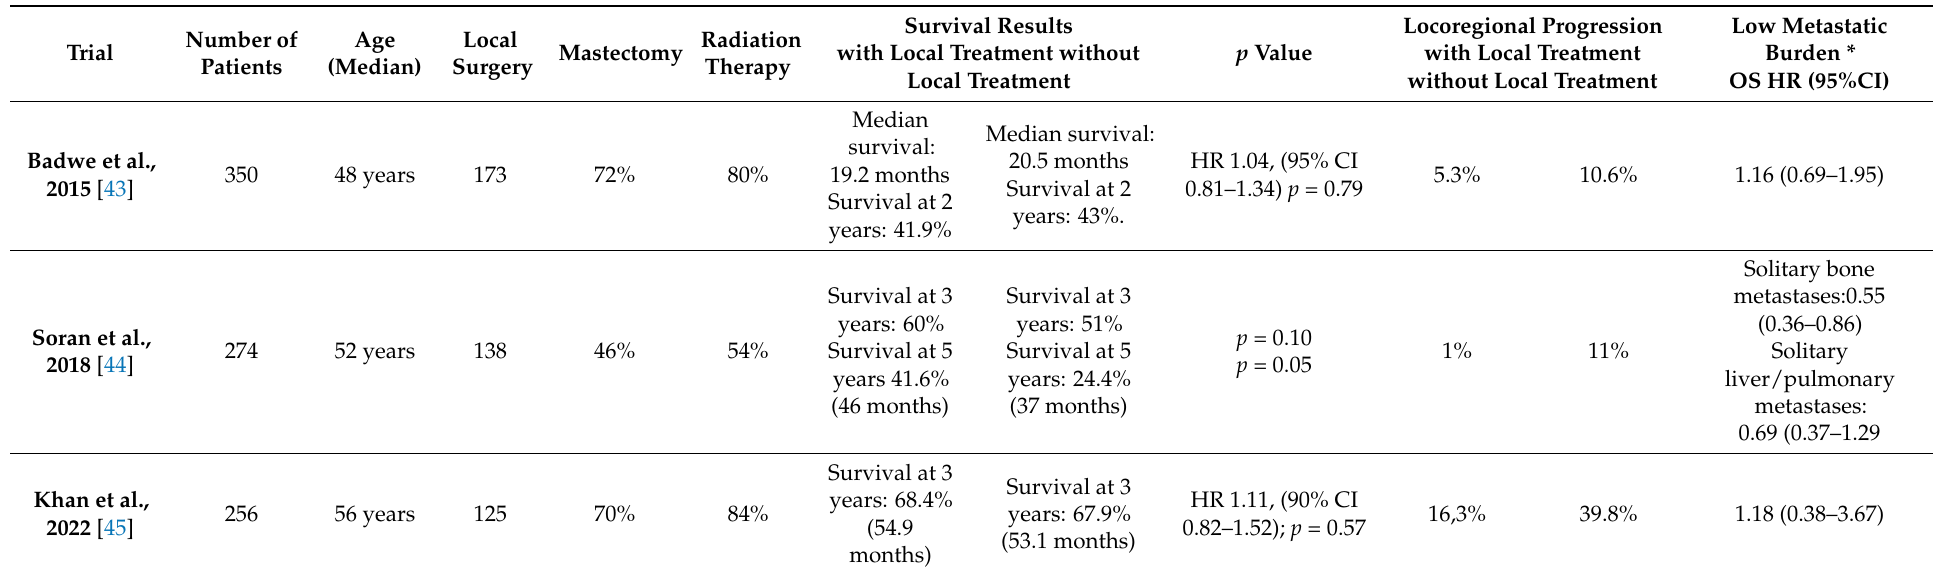
Table 2. Published randomized trials for metastatic breast